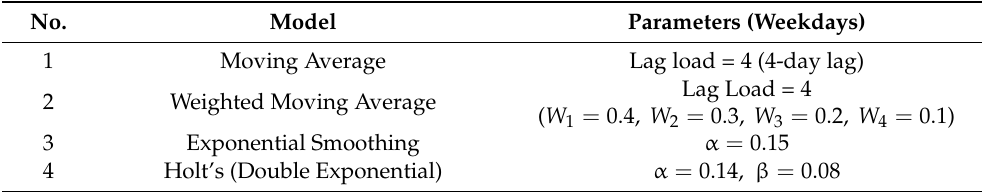
Table 1. Parameter selection of the time series